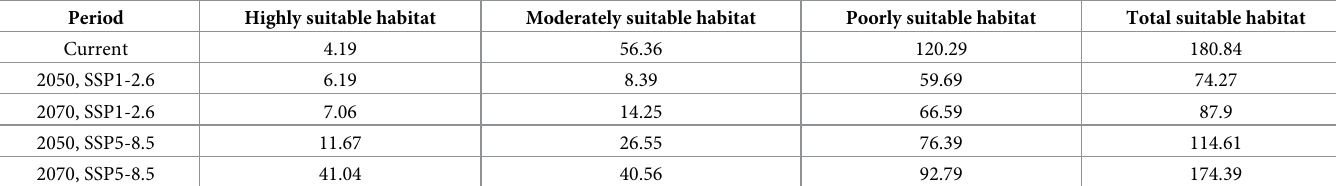
Table 2. Suitable areas for P . tatarinowii under climate change scenarios (10 4 km 2